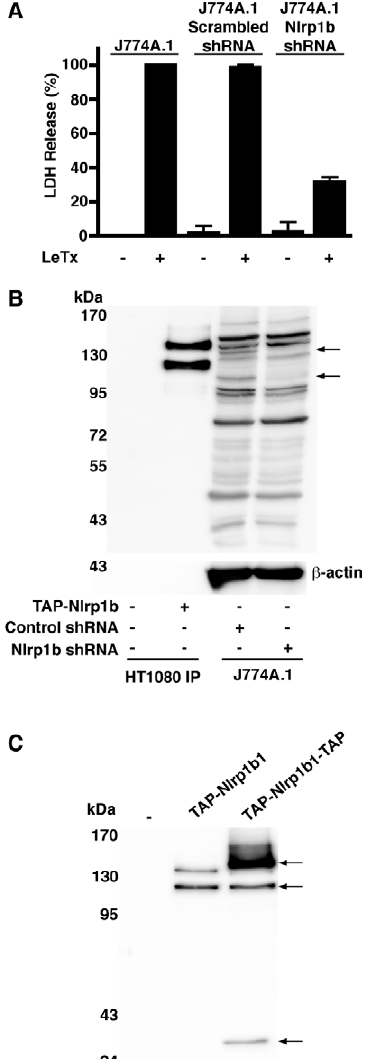
Figure 4. Nlrp1b1 is cleaved within the FIIND. (A) Untransduced J774A.1 cells, or J774A.1 cells stably expressing scrambled shRNA or Nlrp1b shRNA were treated with LeTx (10 2 9 M LF and 10 2 8 M PA) for 4 h and cell supernatants were assayed for LDH activity as an indication of cell death. Error bars indicate SEM of three independent experiments. (B) HT1080 cells were either transfected with pNTAP empty vector or pNTAP-Nlrp1b1. Approximately 24 h after transfection, cells were lysed and TAP-tagged proteins were precipitated with streptavidin resin. Precipitated TAP-tagged proteins and lysates from J774A.1 cells stably expressing either scrambled shRNA or Nlrp1b shRNA were subjected to immunoblotting using an anti-Nlrp1b1 antibody. Arrows indicate two bands present in control, but not in Nlrp1b1 knockdown lysates. (C) HT1080 cells were transfected with either pNTAP empty vector, pNTAP- Nlrp1b1, or pNTAP-Nlrp1b1-TAP. Approximately 24 h following trans- fection, cells were lysed and TAP-tagged proteins were precipitated with streptavidin resin and immunoblotted using an antibody directed against the TAP tag. Arrows indicate full-length Nlrp1b1 and two cleaved fragments of